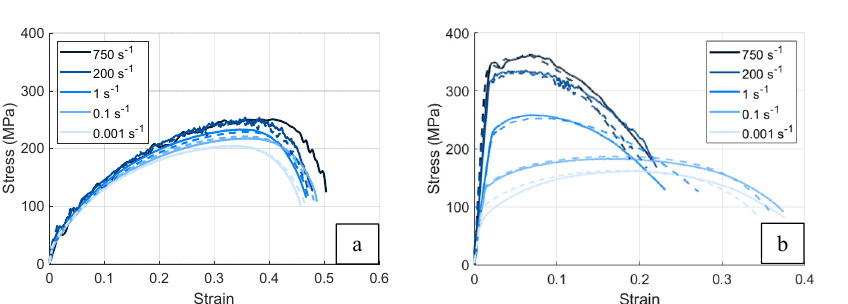
Fig. 6. Stress-strain (engineering) curves obtained at the five strain-rate levels for a) OFE copper and b) high purity niobium EB